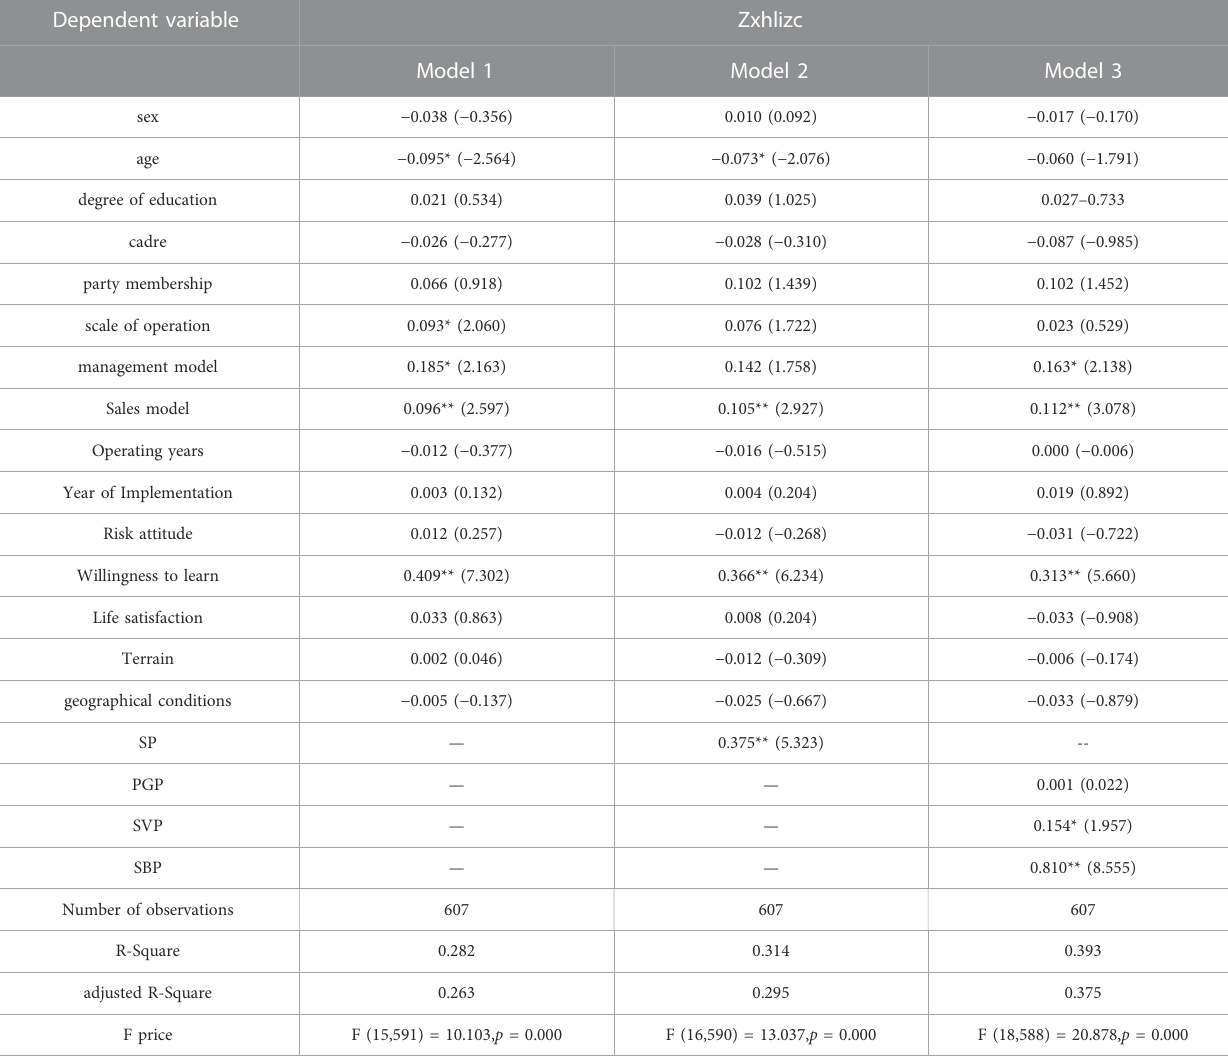
TABLE 3 OLS regression results of support policies ’ impact on farmers ’ willingness to utilize manure